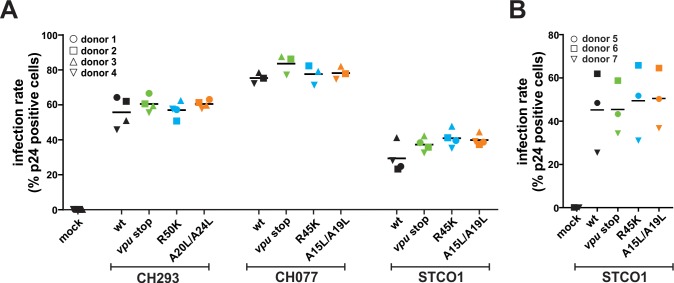
Infection rates of CD4 +T cells.(A) Infection rates of donors analyzed in Figure 4A. (B) Infection rates of donors analyzed in Figure 4B and C. Human CD4 +T cells were infected with the indicated VSV-G pseudotyped HIV-1 strains. Three days post-infection, infection rates were determined by intracellular staining for p24 and subsequent flow cytometric analysis. Horizontal lines indicate mean values of three to four donors.